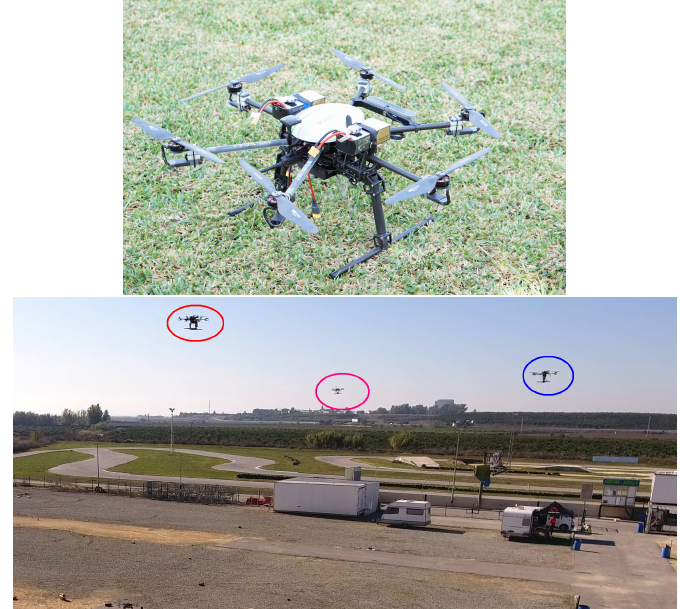
Figure 4. On top , close view of one of our custom-designed UAVs. At the bottom , a view of the experimental site. The colored circles indicate three flying